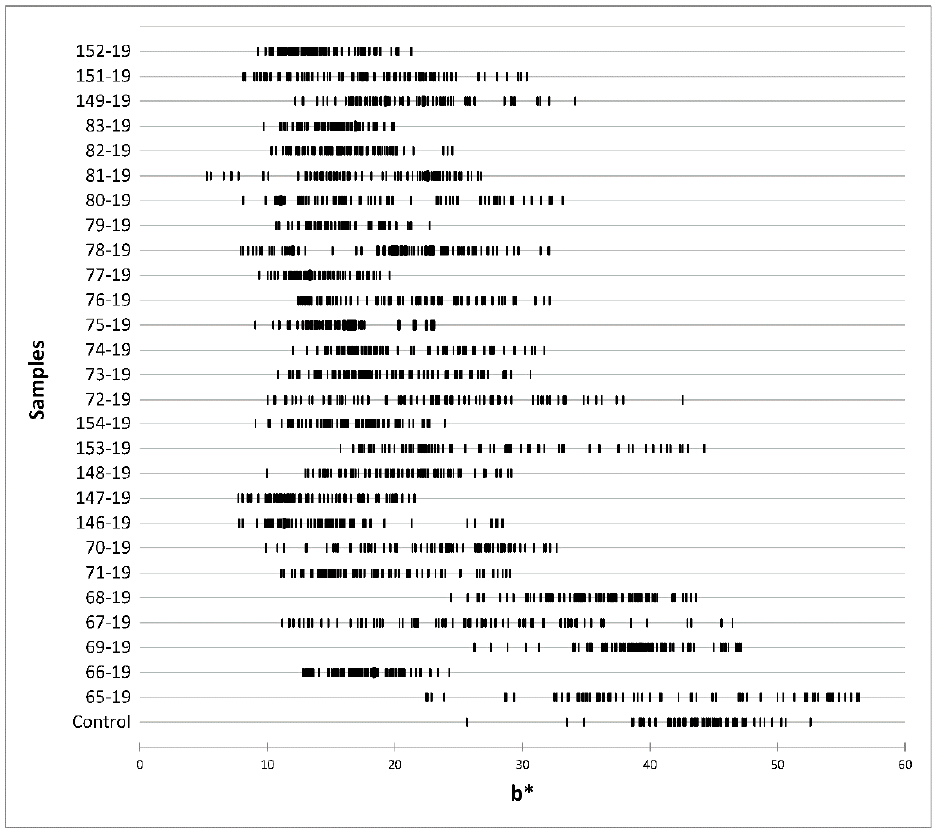
Figure 4. Individual value plot of CIE b* measurement variability of retail market samples.